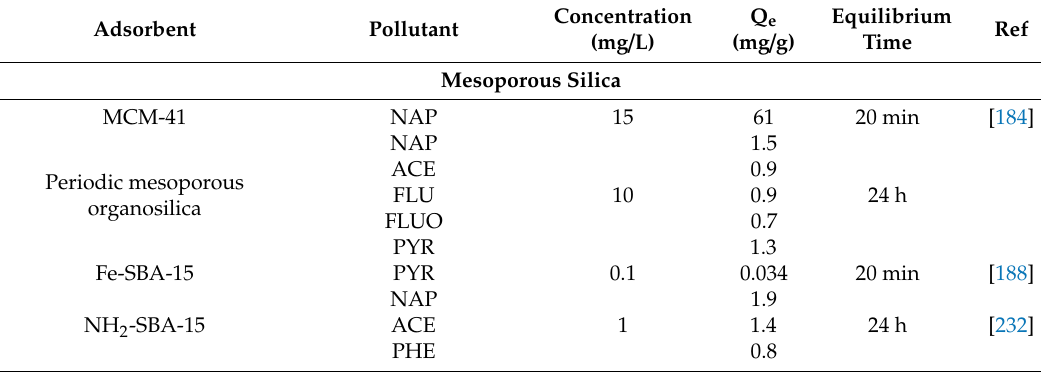
Table 9. Adsorption of PAHs and phenols onto mesoporous silica, MIPs, and metal-organic frameworks (MOFs). Adsorbent